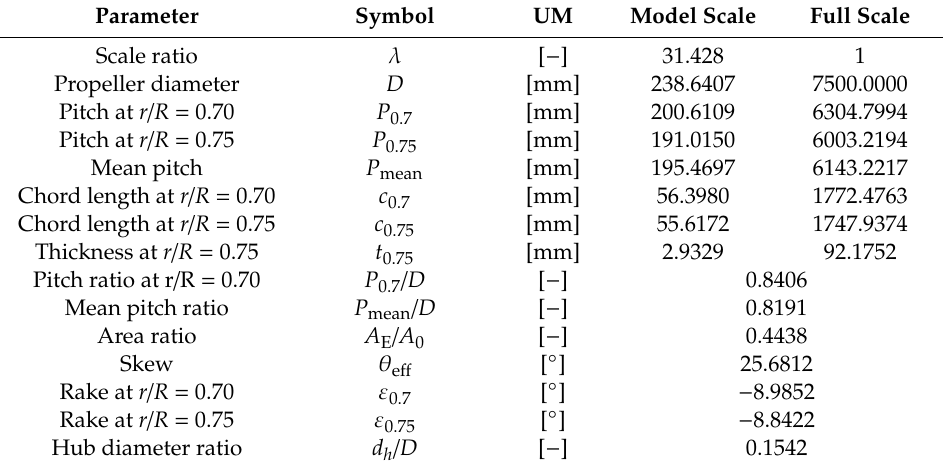
Table 1. Main geometric characteristics of the P1727 propeller.